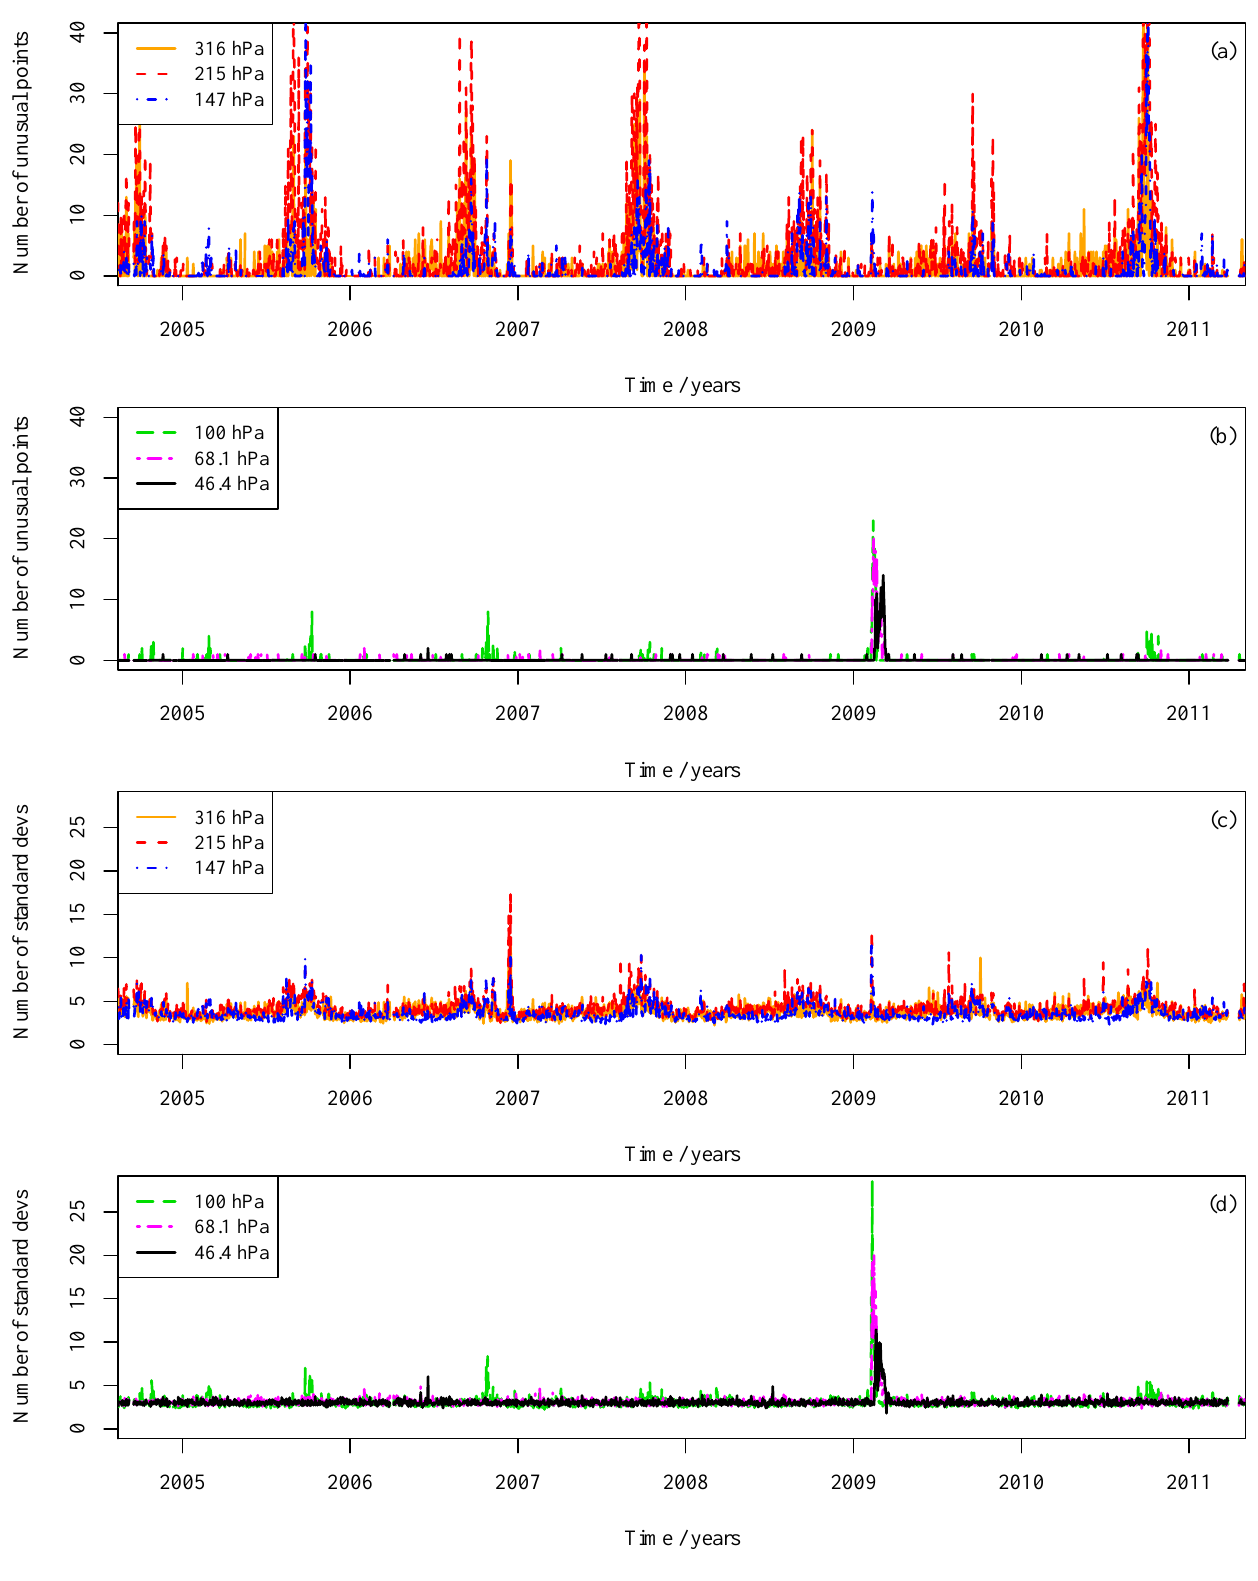
Fig. 11. MLS CO data analysed as in Figs. 3 and 4 but for the entire mission. The troposphere and stratosphere levels are plotted on separate panels to improve clarity. Panels (a) and (b) are equivalent to Fig. 3; (c) and (d) are equivalent to Fig.